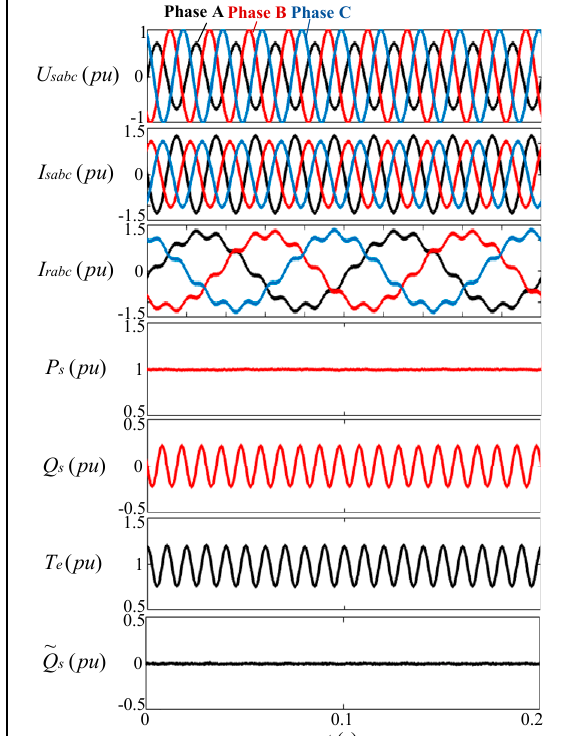
Figure 7. Proposed VSG control under a single-phase grid voltage drop of 30% (Target 1).